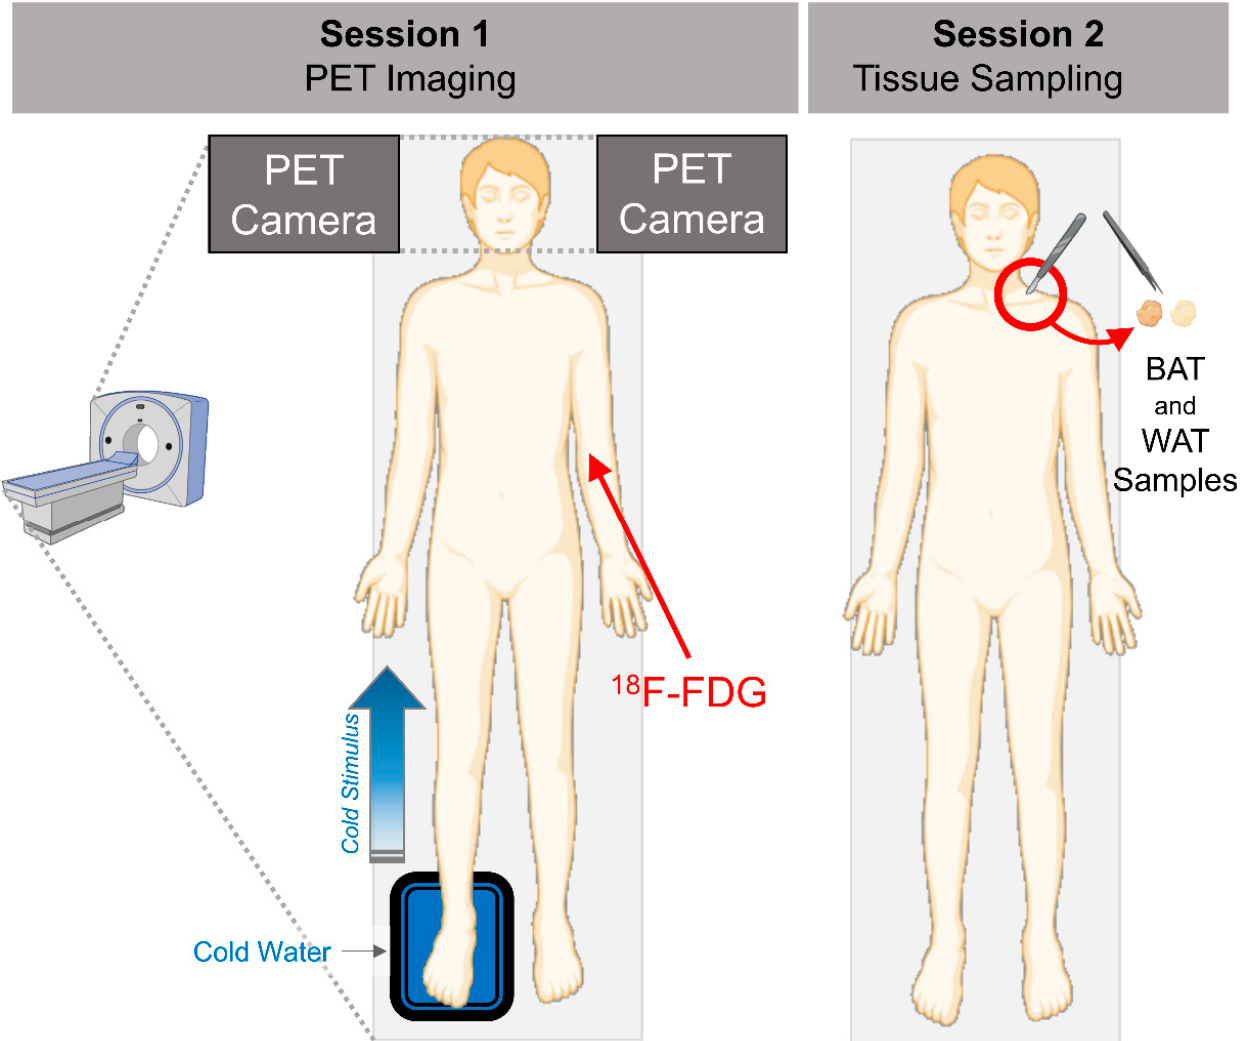
Figure 1. In session 1, PET scanning using an 18 F-FDG radiotracer was conducted with cold water foot immersion to give cold stimulus to the participants. In session 2, an excision biopsy of the fat from the supraclavicular neck region was obtained.